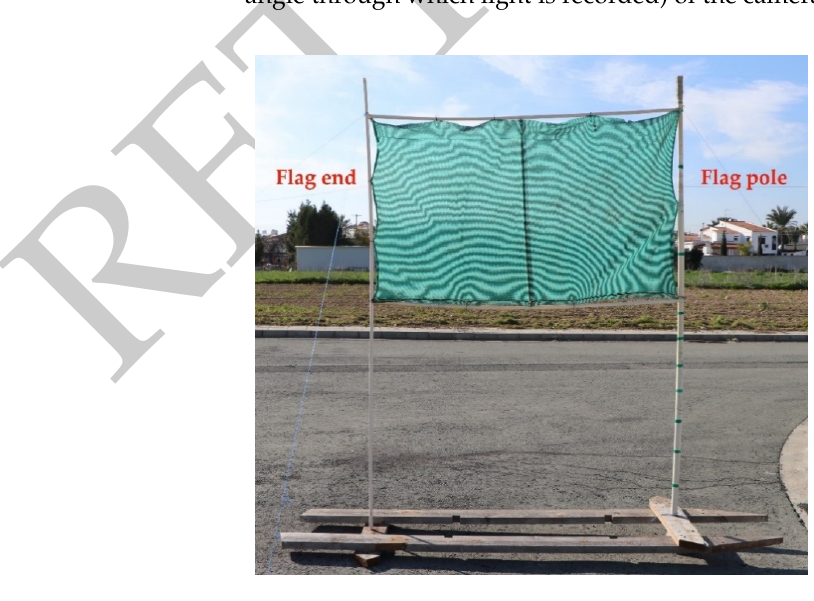
Figure 14. Reconstruction of the pole and the flag at the exact dimensions stated for Apollo 17 mission (flag, 1.09 m × 1.83 m—estimated pole height 2.5 m). The plastic pipe at the flag end is extended by 0.2 m to match the apparent position of the Earth above the top end of the flag.